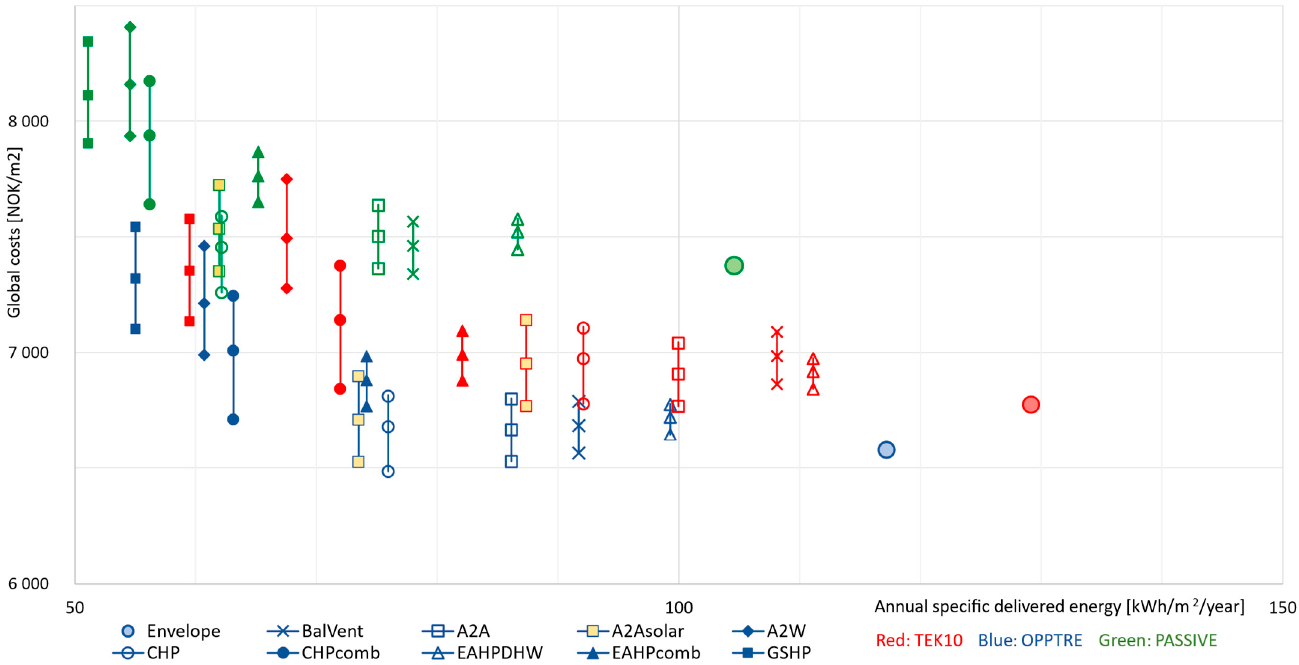
Figure 12. Difference in total specific energy costs between power tariff and original tariff for a calculation period of 20 years. Baseline case with nighttime heating setback.